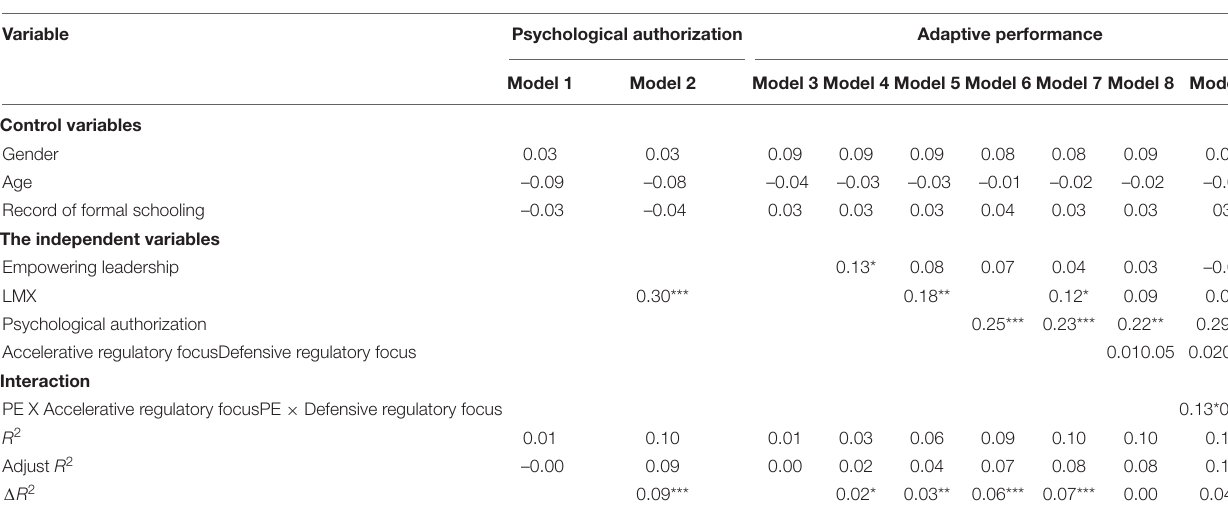
TABLE 3 | Regression analysis